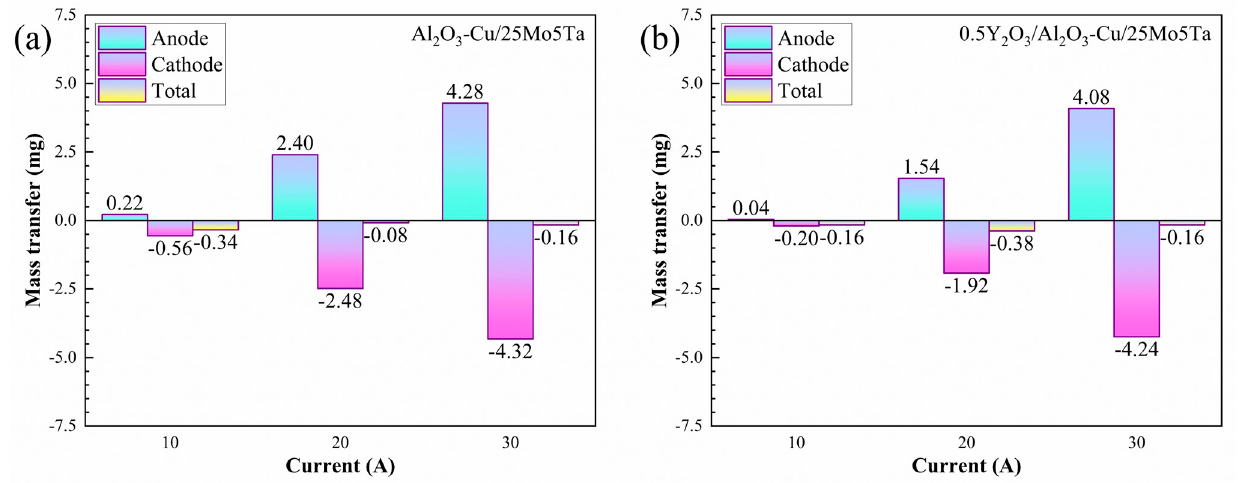
Figure 2. Mass transfer for electrical contacts in different current: ( a ) Al 2 O 3 -Cu/25Mo5Ta composites; ( b ) 0.5Y 2 O 3 /Al 2 O 3 -Cu/25Mo5Ta composites.